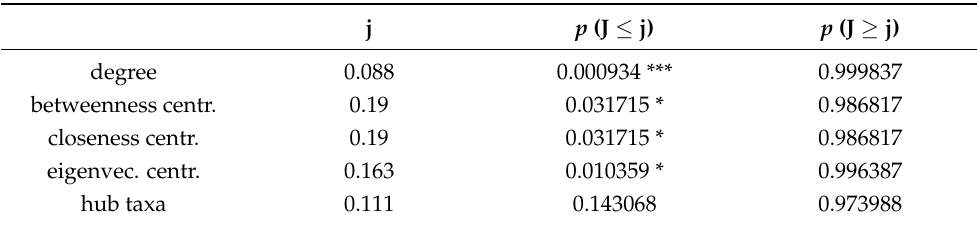
Table 3. Jaccard index values of the most central nodes and hub taxa between the two networks of grass-fed and grain-fed rumen